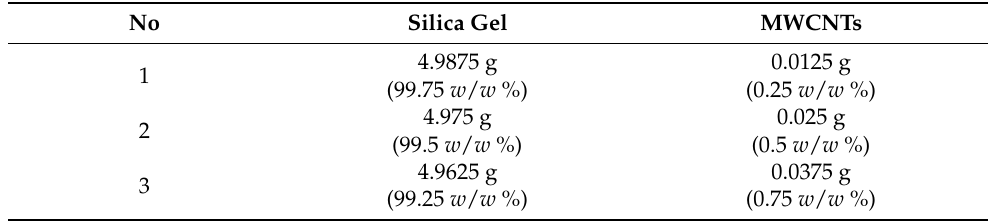
Table 2. Concentrations of various prepared composites of silica gel and MWCNTs and the amounts used in